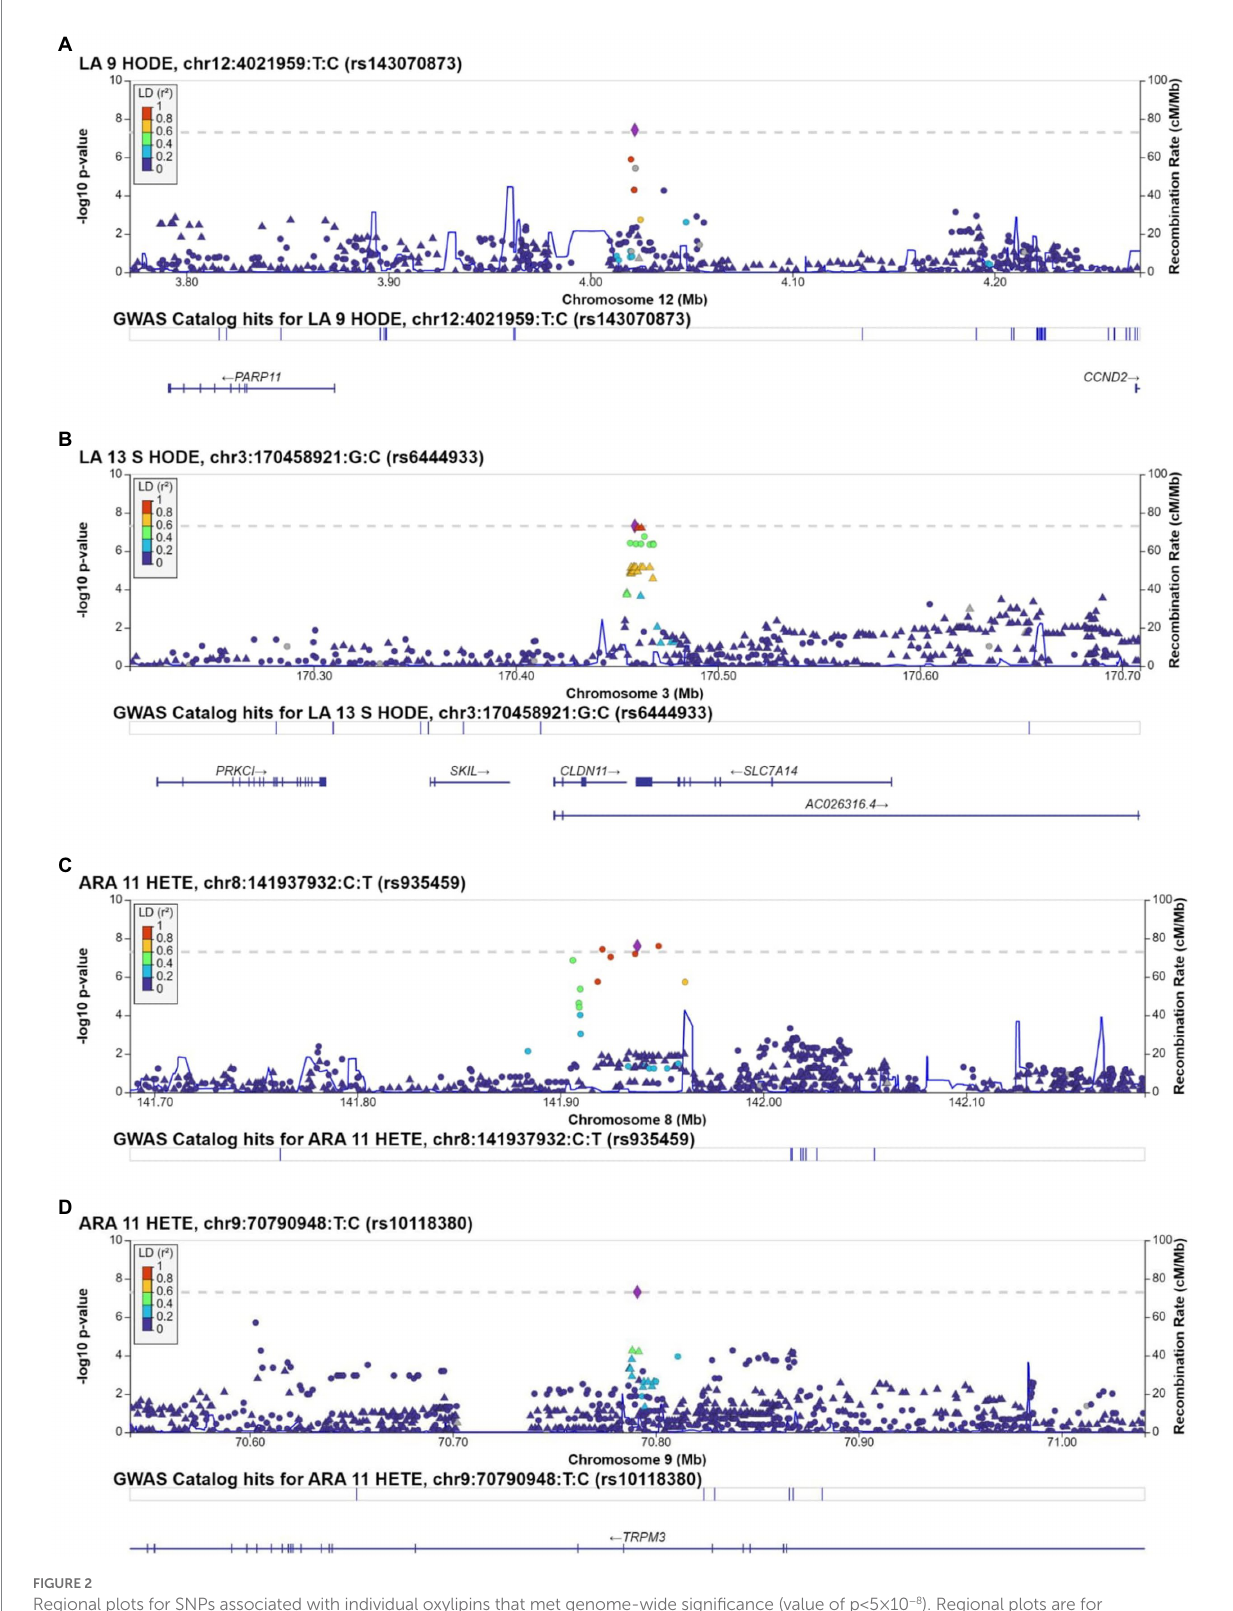
FIGURE 2 Regional plots for SNPs associated with individual oxylipins that met genome-wide significance (value of p<5 × 10 − 8 ). Regional plots are for rs143070873, associated with 9-HODE (A) ; rs6444933, associated with 13 S-HODE (B) ; rs935459, associated with 11-HETE (C) ; and rs10118380, associated with 11-HETE (D) . Chromosome and physical location (Mb) are on the X-axis. Negative base ten logarithm of the p -values is on the left Y-axis, and recombination activity (cM/Mb) is shown on the right Y-axis as a blue line. Positions, recombination rates, and gene annotations are according to NCBI’s build 38 (hg 19) and the 1,000 Genomes Project Phase 3 multiethnic data set. LD is calculated for a European population. Plots display +/ − 500,000BP of the selected